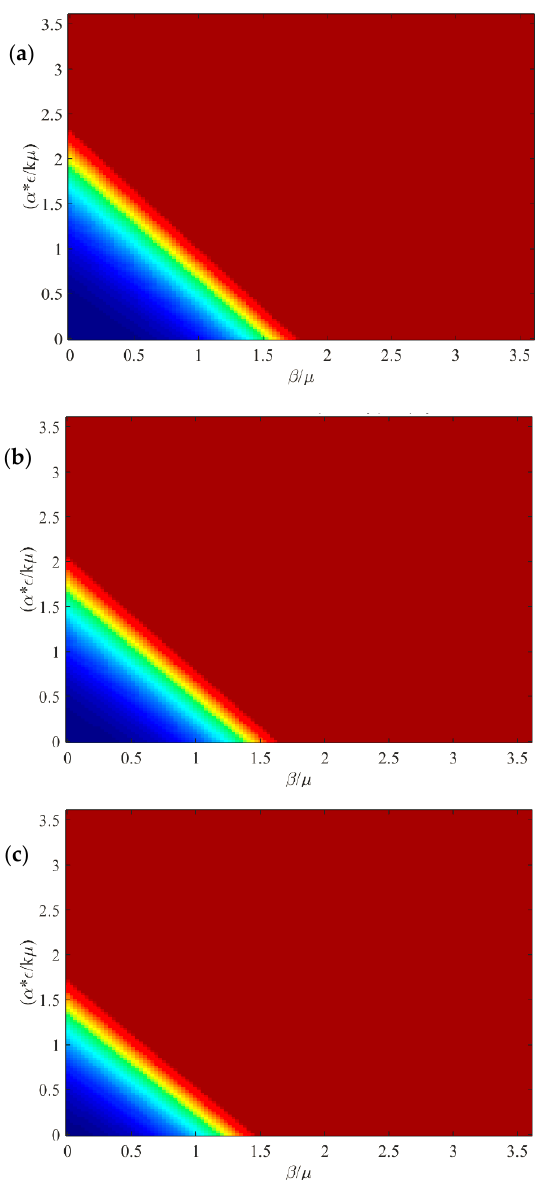
Figure A1. Sensitivity analysis of initial conditions at t = 100 days with parameters used in Table 1. The heat map shows the fraction of infectious as a function of 𝑹 𝒅𝒊𝒓𝒆𝒄𝒕 = the range of initial infectious fraction in the population listed as: ( a ) 𝑰 𝟎 = 𝟎.𝟎𝟑 , ( b ) 𝑰 𝟎 = 𝟎.𝟎𝟓 , ( c ) 𝑰 𝟎 = 𝟎.𝟏𝟎 .